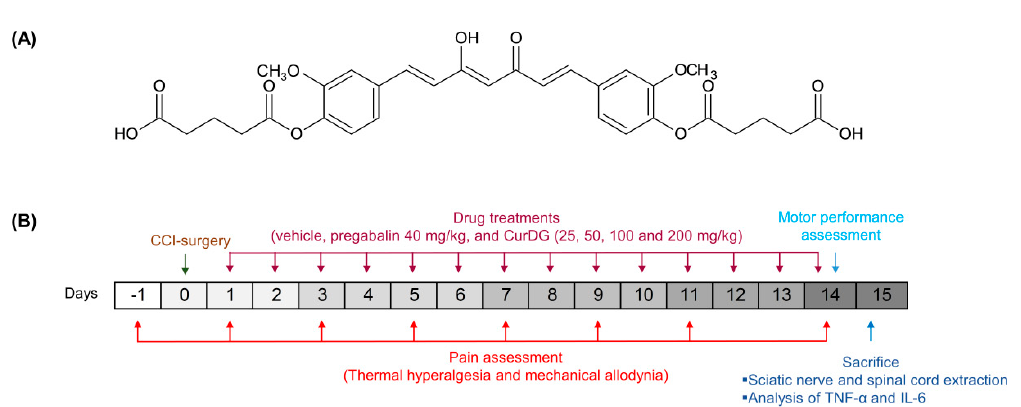
Figure 1. ( A ) Chemical structure of curcumin diglutaric acid (CurDG), and ( B ) the schematic illustration of experimental design.